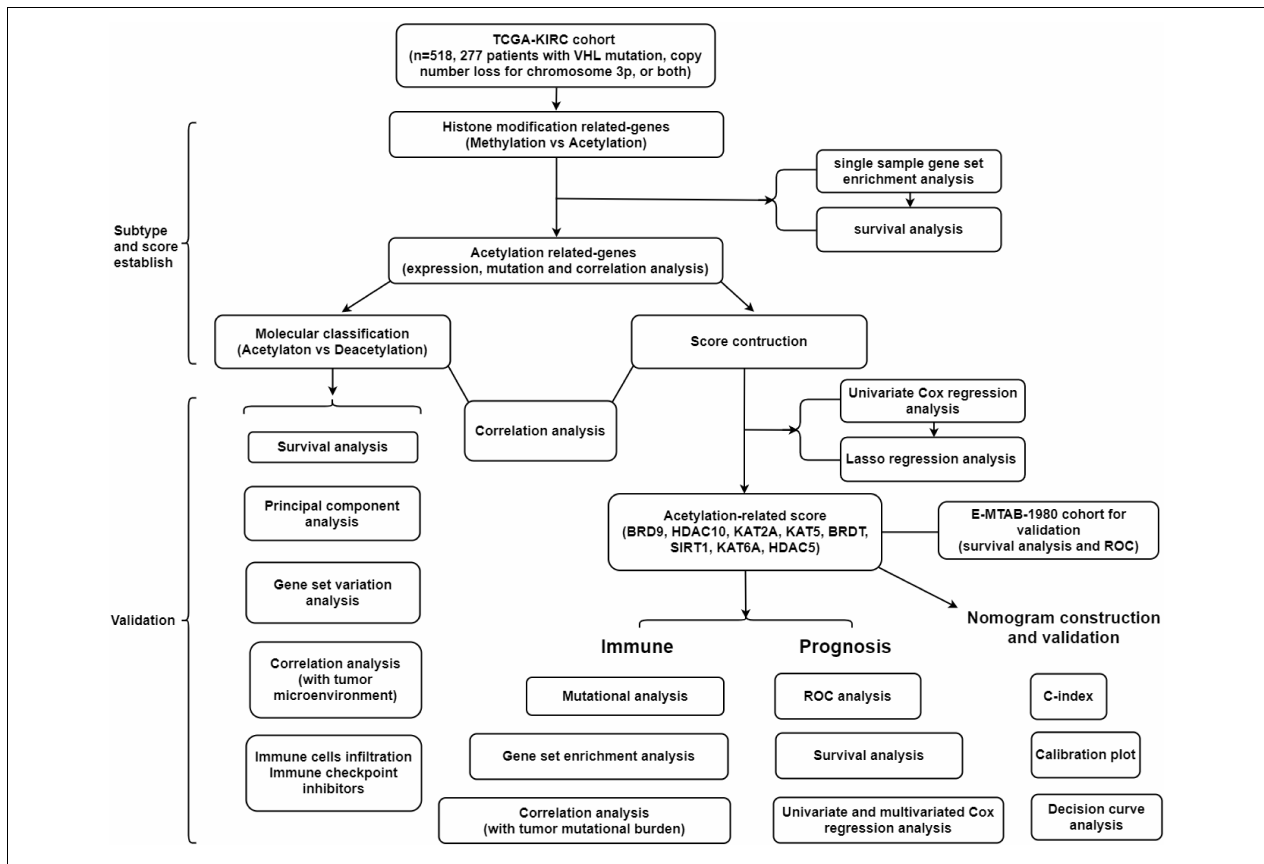
FIGURE 1 | The flowchart of this